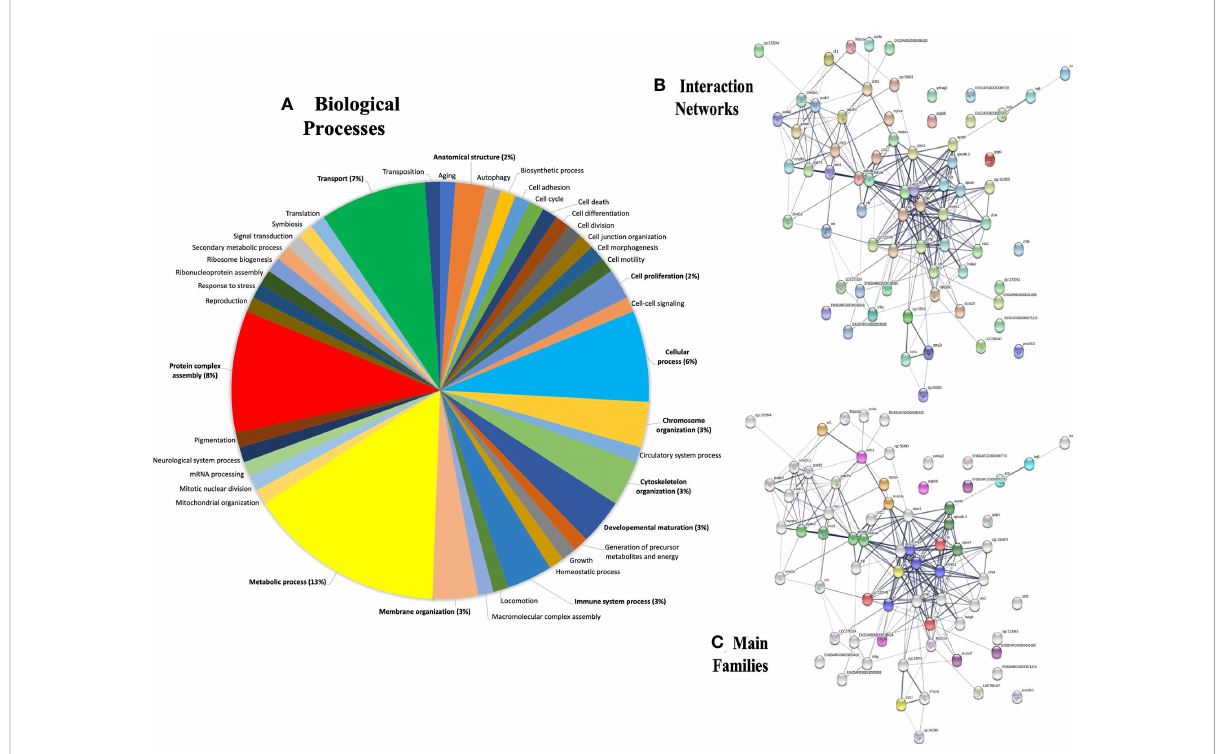
FIGURE 6 Gene ontology (GO) annotations retrieved from plasma proteins in the zebra fi sh l -CGN-induced in fl ammatory reaction after 4h. (A) The forty- two differentially expressed genes were involved in biological processes, mainly in metabolic process (13%) and transport (7%) as the top terms. (B) Major protein-protein interaction network among hub protein clusters in the blood plasma of l -CGN-induced fi sh. The stronger associations are represented with thicker lines. (C) Functional pathway network showing the distribution of pathways associated with the complement system and blood coagulation cascade identi fi ed through the functional enrichment analysis of l -CGN-treated fi sh. The color depth of nodes refers to the corrected p-value of the ontologies represented: (purple, immunoglobulins; green, apolipoproteins; orange, complement; blue, fi brinogen). Hierarchical clustering of hub protein-protein interaction networks functional enrichment analysis was constructed using STRING (https://string-db.org). The associations between the twenty-seven proteins of this signaling pathway were predicted using the KEGG tool. Names and taxonomy retrieved from UniProtKB (See Table 1 for accession numbers): Keratin 5 (Krt5); Keratin 8 (Krt8); Co fi lin 1 (C fl 1); Myosin heavy chain 4 (Myhc4); Actin (Actb1); Retinol binding protein 4 (Rbp4); Alpha-2-macroglobulin-like protein (A2ml); Alpha- 2-macroglobulin-like 1 (Si:dkey-105h12.2); Alpha-2-macroglobulin (Sb:cb37); Apolipoprotein Eb (Apoeb); Apolipoprotein A-IV b,2 (Apoa4b.2); Apolipoprotein A-IV b,1 (Apoa4b.1); Phosphoglycerate mutase (Pgam2); Phosphopyruvate hydratase (Eno1); Fructose-bisphosphate aldolase,